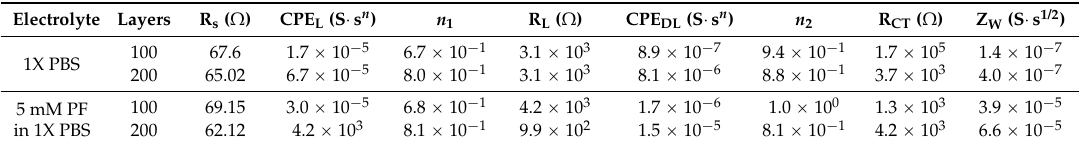
Figure 4. Impedance plots of paper-based electroanalytical device. ( a ) The Nyquist diagram, ( b , c ) Bode plots of the 200 and 100-layered HA-CNT sheet working electrodes between 1 MHz and 0.2 Hz frequency in 1X PBS ( left ) and 5 mM K 3 [Fe(CN) 6 ] in 1X PBS solution ( right ) in an Origami paper-based chip. ( d ) Equivalent circuit for the impedance spectra of the paper-based electroanalytical device. The dots and lines noted in (a–c) represent experimental data and (d) a model of an equivalent circuit. Table 1. Electrochemical parameters of equivalent circuits obtained from best fit to impedance data for paper-based electroanalytical devices.